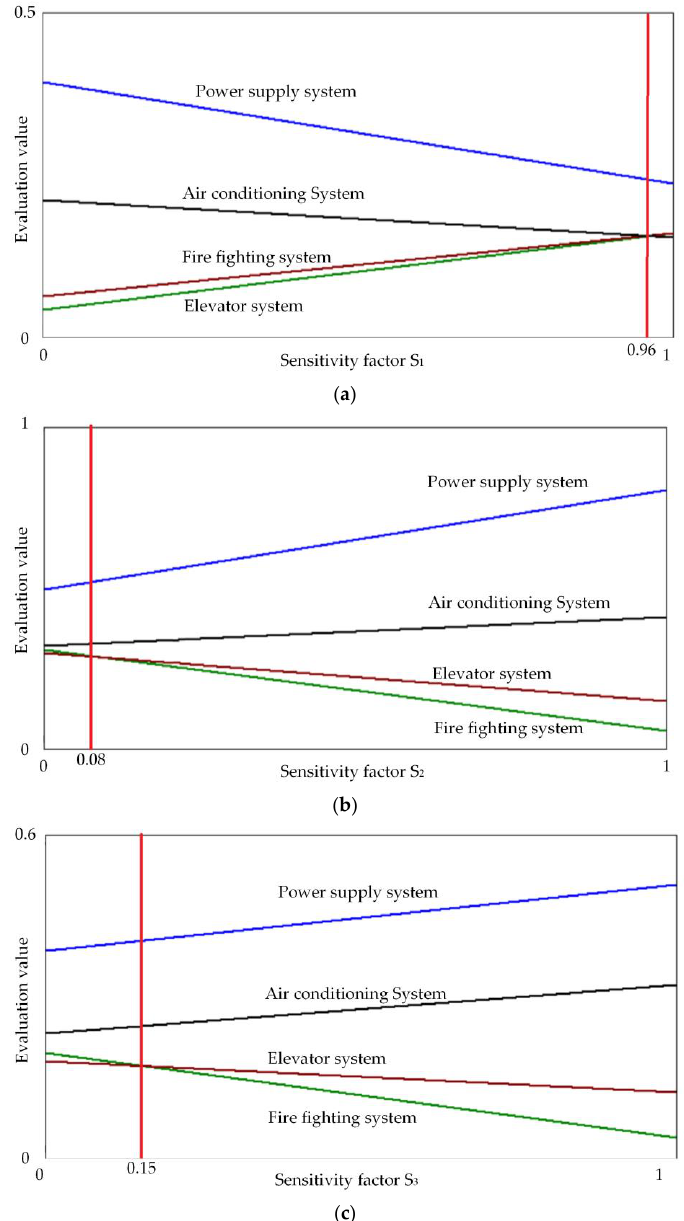
Figure 8. Sensitivity analysis of the power supply, air conditioning, firefighting, and elevator systems: ( a ) sensitivity factor S 1 was added to O 1 cost factor; ( b ) sensitivity factor S 2 was added to O 2 labor costs; ( c ) sensitivity factor S 3 was added to O 3 affecting operating quality.